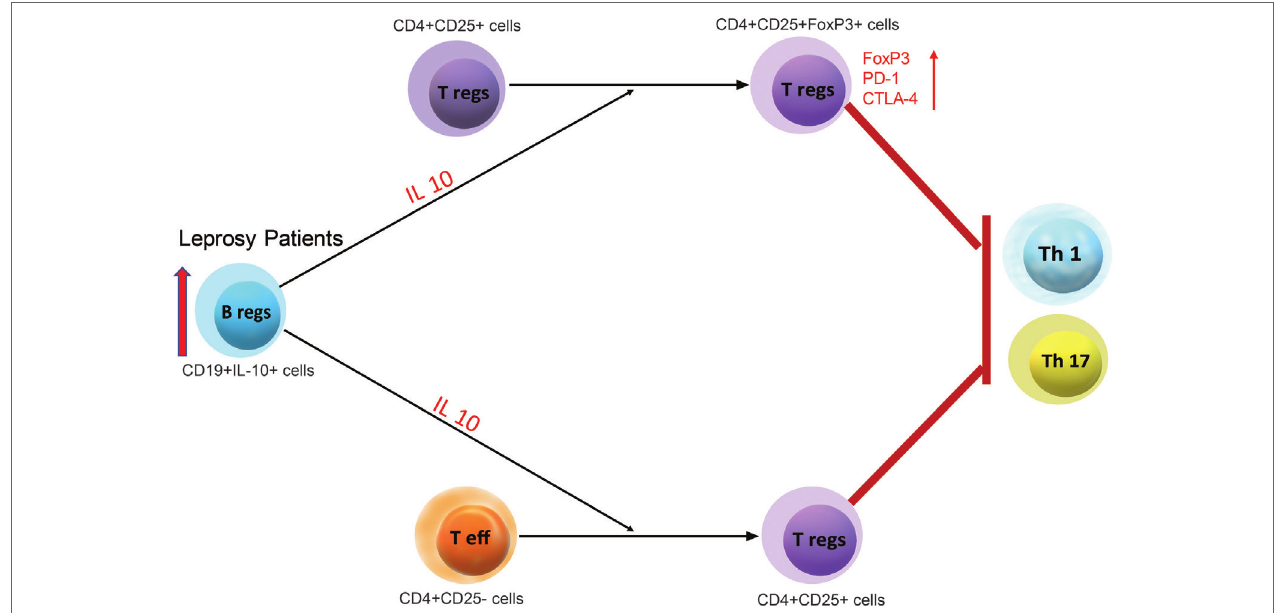
FigUre 7 | A schematic representation for the regulatory function of leprosy derived regulatory B cells (Bregs) (CD19 + IL-10 + ) and its regulatory function on Teff (CD4 + CD25 − ) and Tregs (CD4 + CD25 +